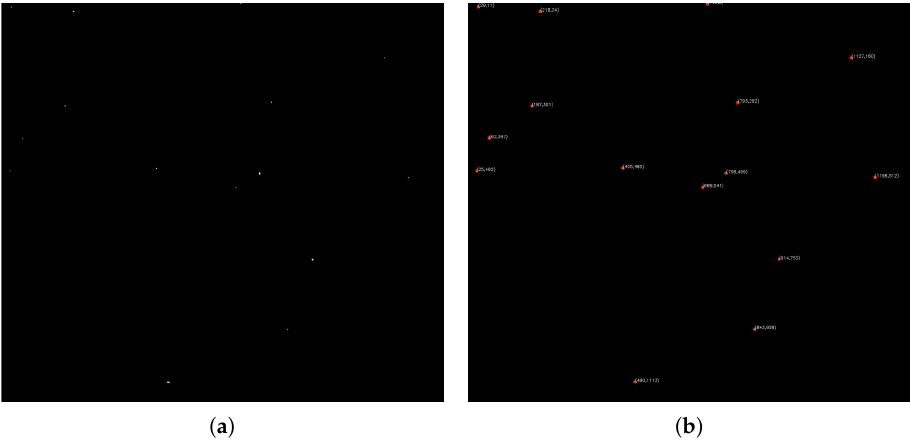
Figure 12. ( a ) is foreground map obtained from pre-ViBe; ( b ) is the result of centroid detection. It can be seen from the figure that we have located the coordinates of all the targets in the